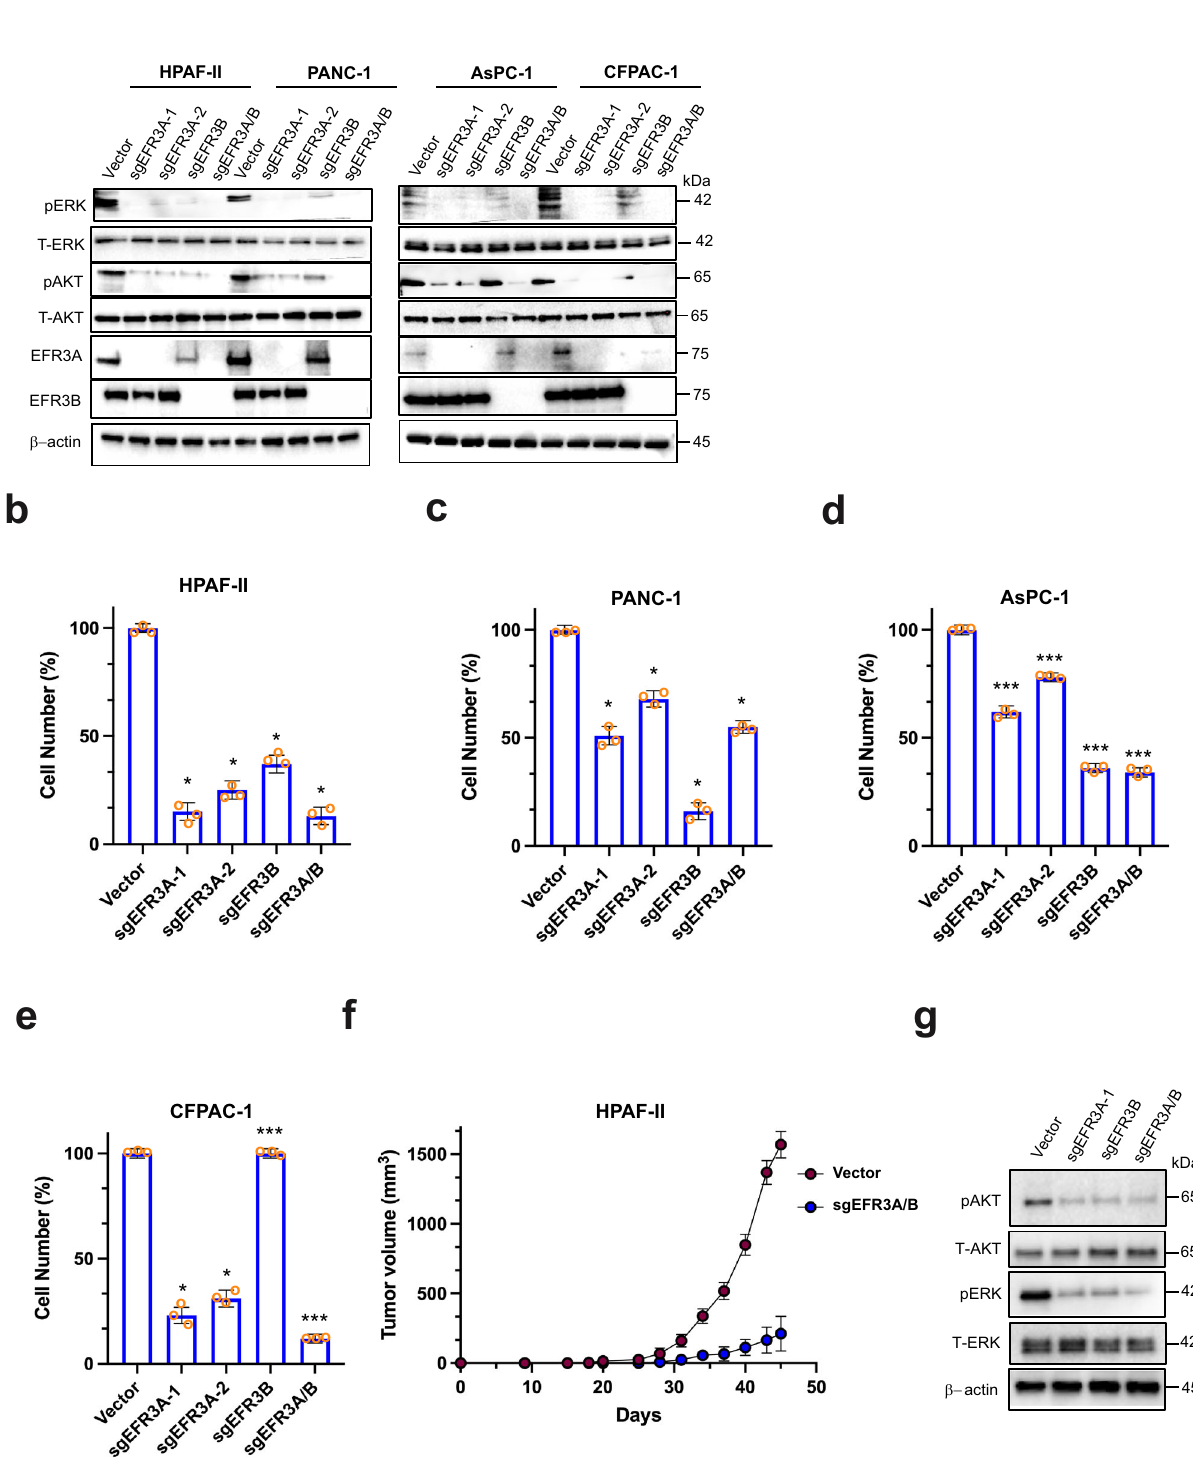
protein puri fi ed by af fi nity capture with a Ni-NTA resin. GST- alone as a negative control or the above GST-EFR3A were incubated EFR3A was then incubated with His 10 -KRAS G12V , after which with the above His 10 -KRAS G12V protein. GST or GST-EFR3A His 10 -KRAS G12V was immunoprecipitated with a KRAS-speci fi c protein was then immunoprecipitated with a GST-speci fi c antibody followed by immunoblot with GST- or KRAS-speci fi c antibodies. antibody and immunoblotted with EFR3A- or KRAS-speci fi c anti- This revealed that His 10 -KRAS G12V co-immunoprecipitated with bodies. This revealed that His 10 -KRAS G12V co-immunoprecipitated with GST-EFR3A (Fig. 4e, f). This interaction was corroborated in GST-EFR3A, but not with GST (Supplementary Fig. 5b). To the reverse direction. Namely, similarly puri fi ed recombinant GST determine if this interaction depended upon the activation status of NATURE COMMUNICATIONS| (2021) 12:5248